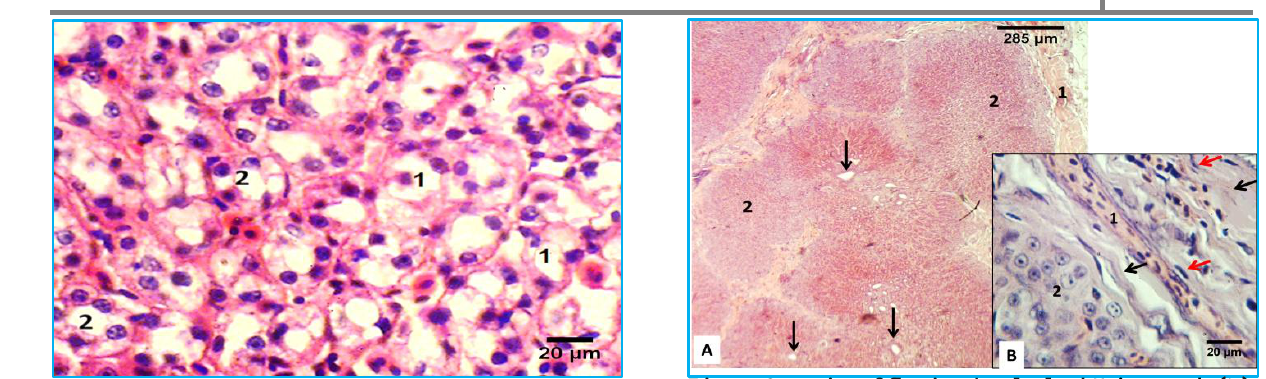
Figure, 6: section of flamingo's salt gland Micrograph (A): Collagenous capsule (1), lobules (2), and central duct (Arrows) H and E stain. Micrograph (B): magnification section of capsule region shows: blood vessels (1), acini with mitotic activities (2), collagen bundles (Black arrows) fibrocytes (yellow arrows) H and E stain.